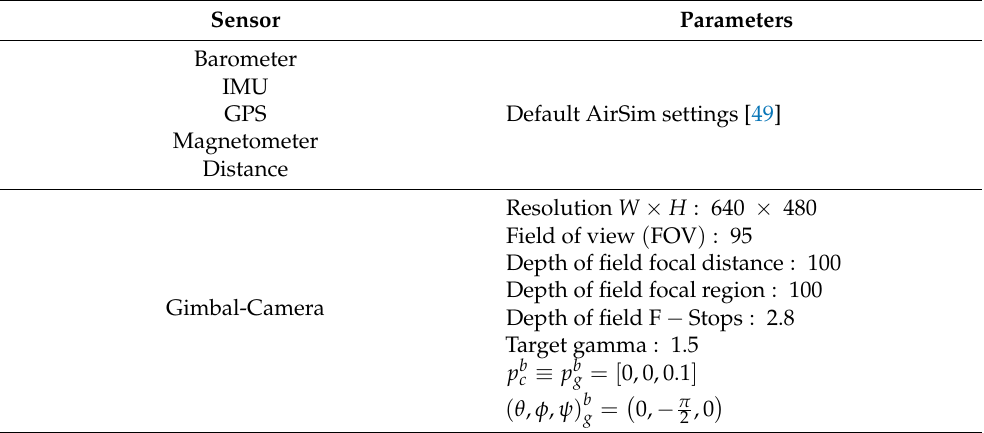
Table 1. Sensor parameters simulated in AirSim.